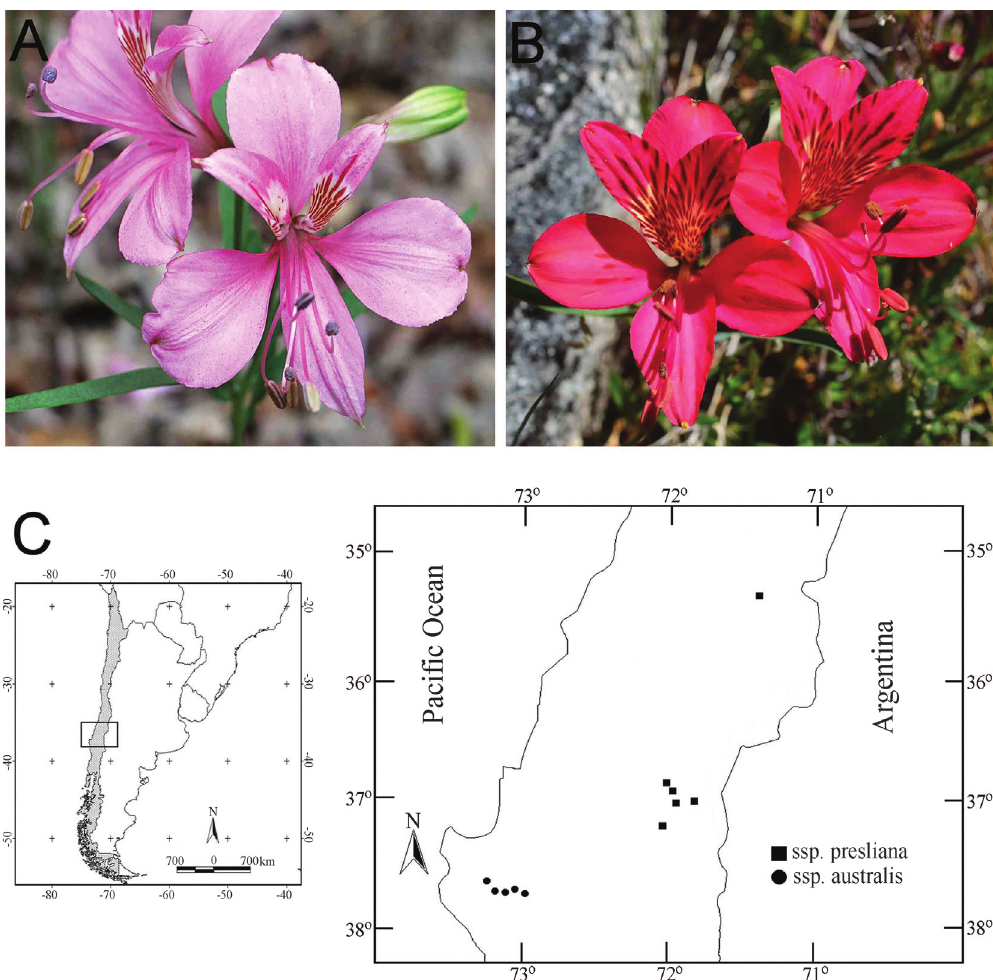
Figure 1 - Photographic representation and geographic distribution of Alstroemeria presliana. (A) Photography of Alstroemeria presliana subsp. presliana; (B) Photography of Alstroemeria presliana subsp. australis; (C) Geographic distribution of the 11 analyzed populations of Alstroemeria presliana